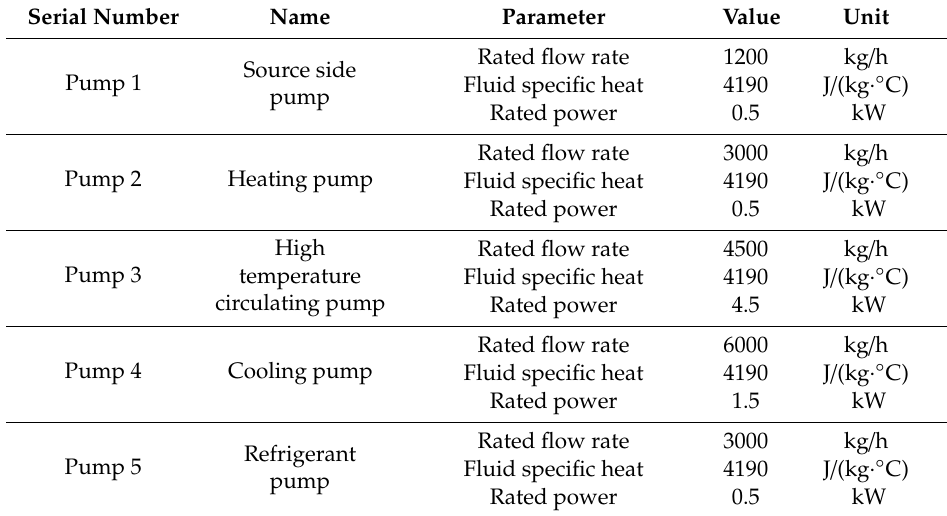
Table A1. Depiction of circulation pumps in the NG-LCPV / T-TG system.